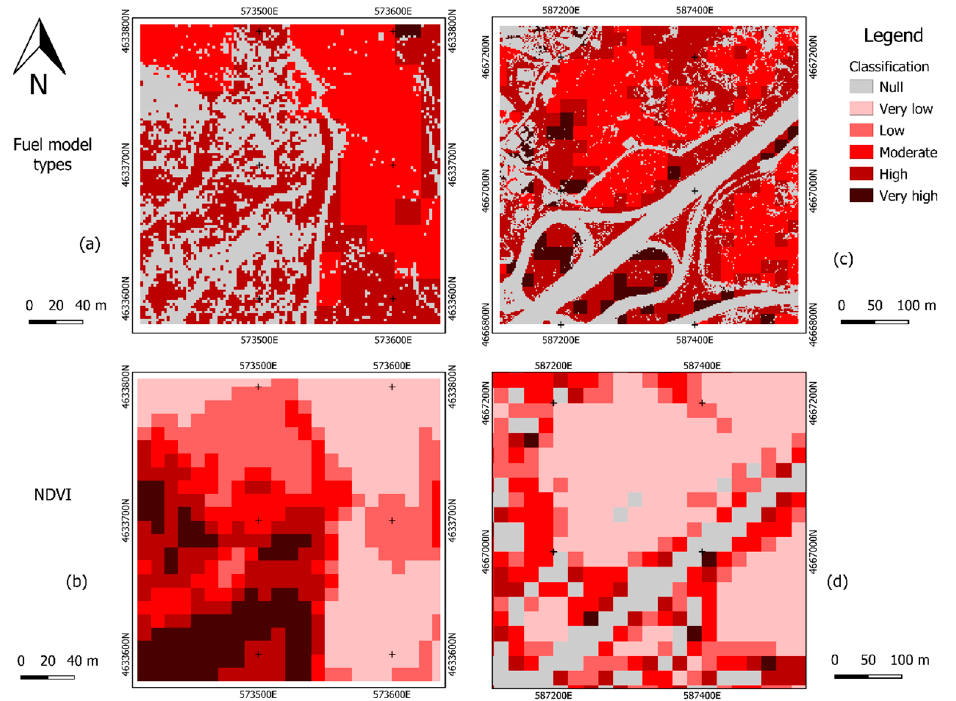
Figure 9. Fuel model (first row) and NDVI (second row) maps classified. ( a ) Fuel model map classified of study area A; ( b ) NDVI map classified of study area A; ( c ) fuel model map classified of study area B; ( d ) NDVI map classified of study area B. The map coordinate system is EPSG:25829 ETRS89 / UTM zone 29N.